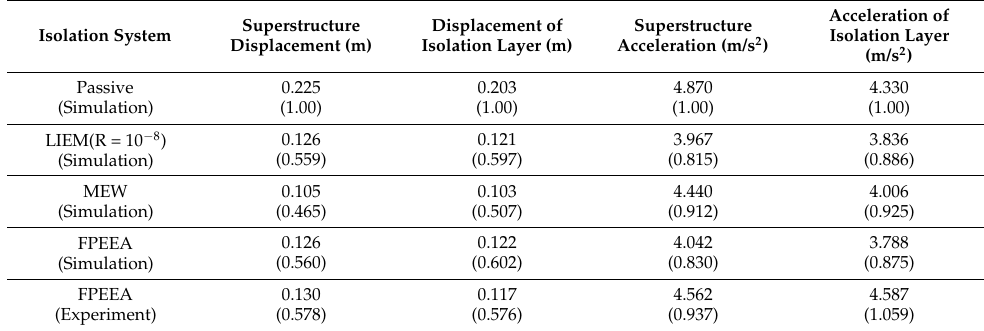
Table 10. Maximum responses of the Northridge (PGA = 0.3 g) earthquake.